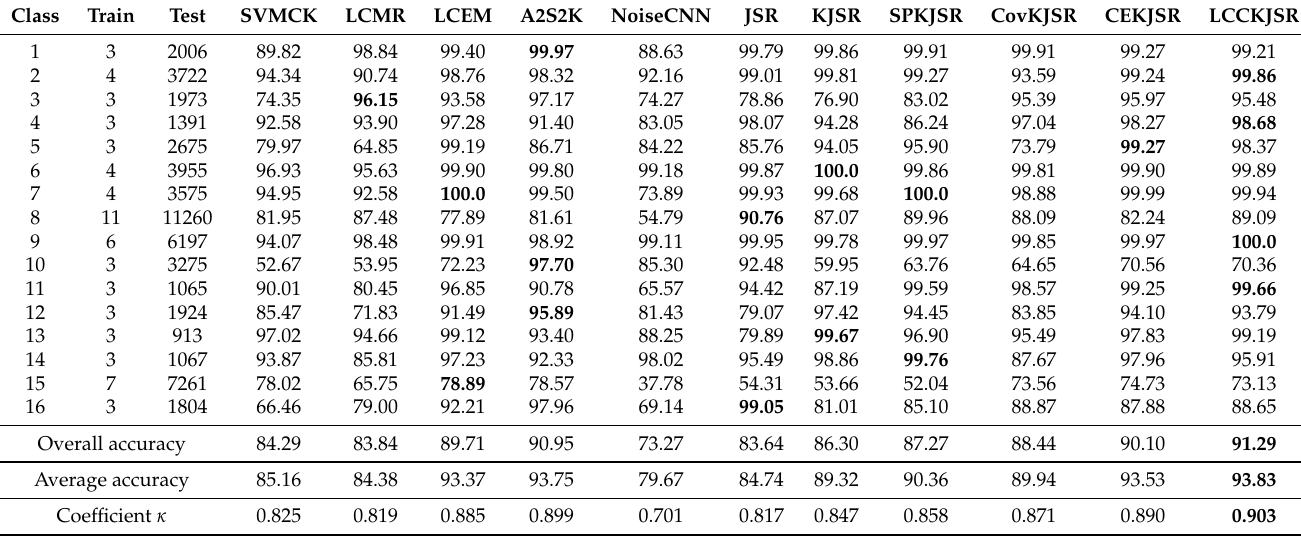
Figure 7. Classification maps on SA. Classification maps on IP: ( a ) Groundtruth, ( b ) SVMCK, ( c ) LCMR, ( d ) LCEM, ( e ) A2S2K, ( f ) NoiseCNN, ( g ) JSR, ( h ) KJSR, ( i ) SPKJSR, ( j ) CovKJSR, ( k ) CEKJSR, ( l ) LMFKJSR. Table 3. Classification results for the Salinas data set with 0.1% labeled training samples (66 train- ing samples). The bold values indicate the highest accuracy among all